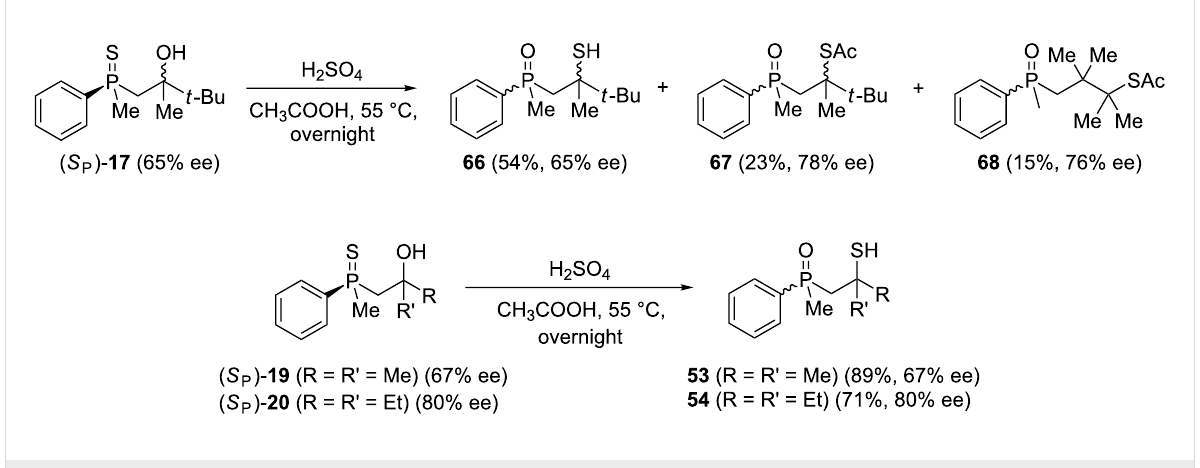
Scheme 13: Reaction of chiral β -hydroxyalkylphosphine sulfides with Brønsted acid.